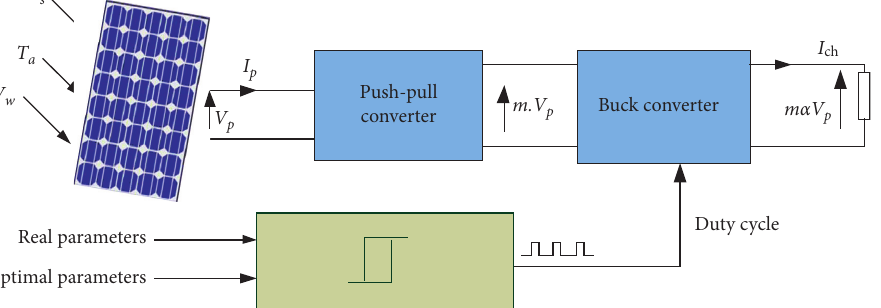
Figure 2: Structure of the study system.